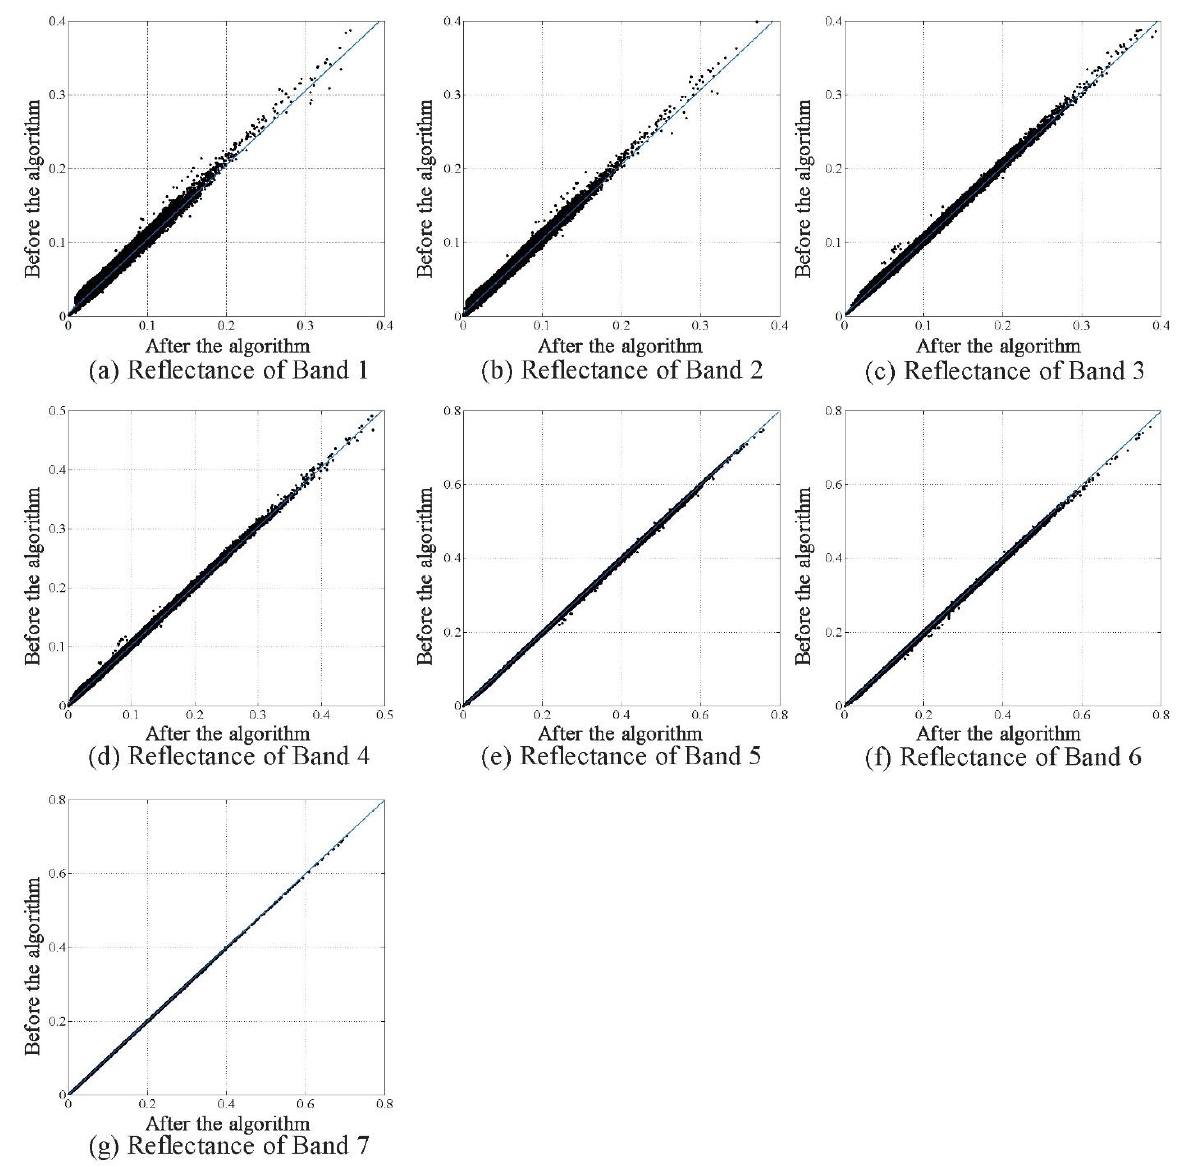
Figure 10. Scatterplots of cloud-free pixels before and after the algorithm. ( a – g ) are Bands 1–7,